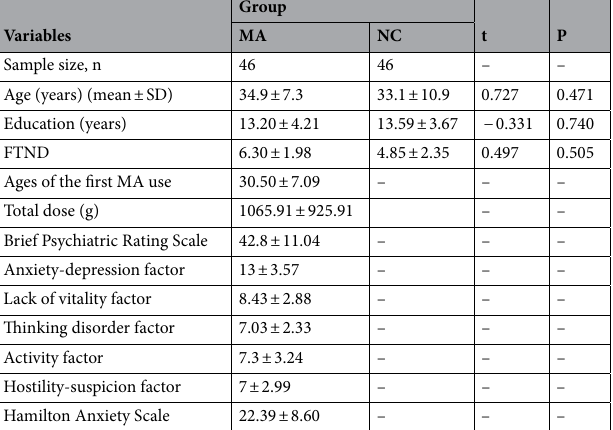
Table 1. Demographic and clinical characteristics of methamphetamine (MA)-dependent patients and normal controls (NCs). FTND, Fagerstrőm test for nicotine dependence.